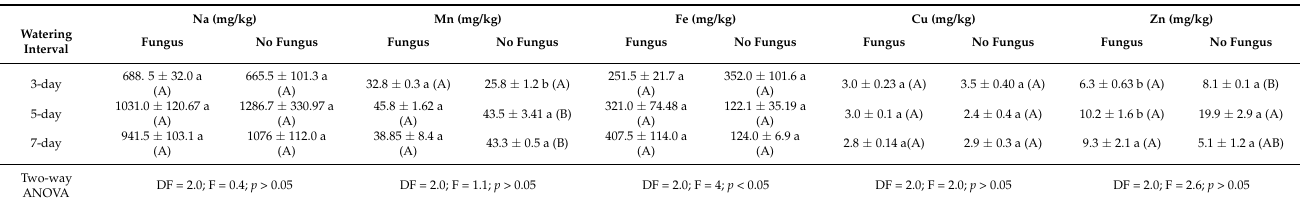
Table 3. Effects of water deficiency and the inoculation of growth medium with B. bassiana on micronutrient content in leaves of A. cepa